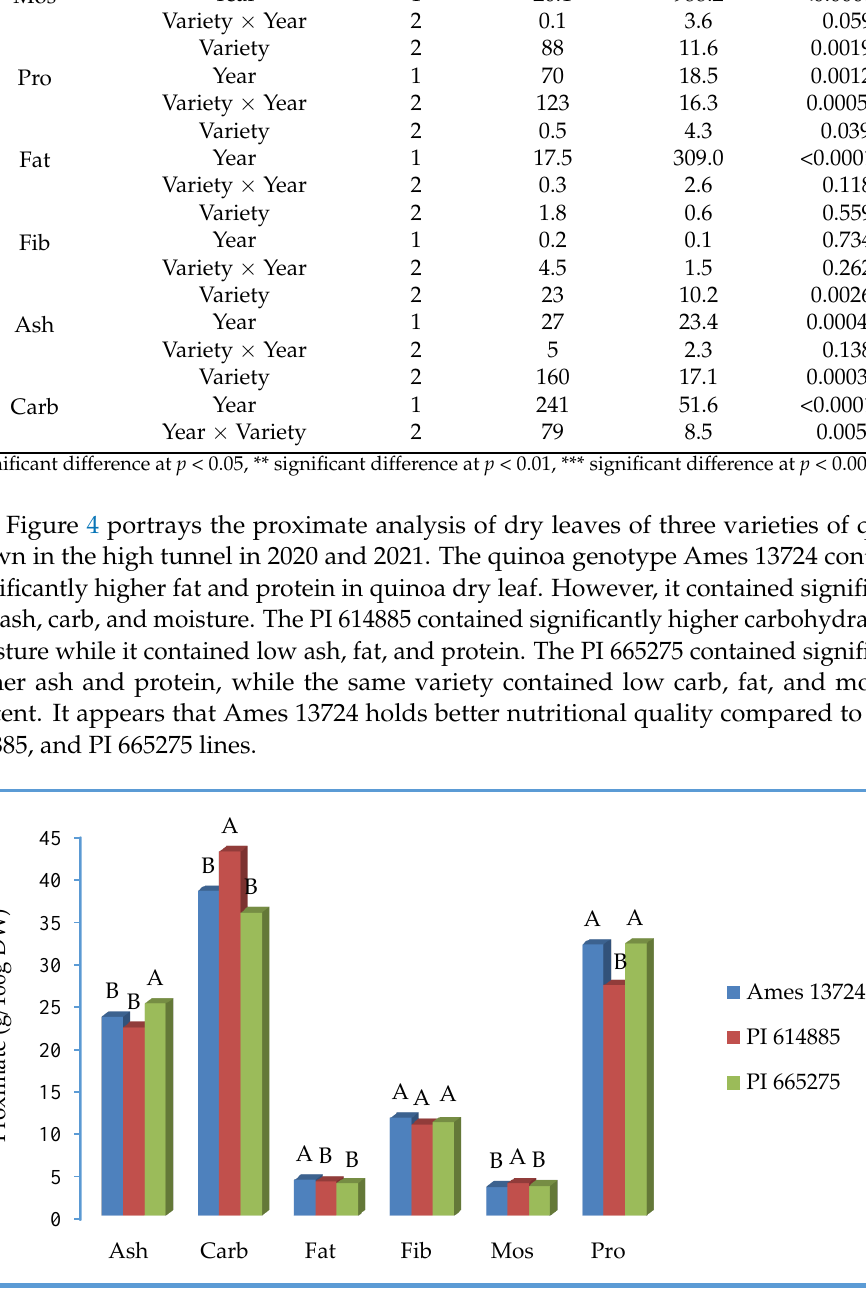
Figure 4. Proximate analysis (g per 100 g DW) of dry leaves of three varieties of quinoa grown in the high tunnel in 2020, and 2021, Lincoln University Carver farm, Jefferson City, MO, USA. Different letters suggest significant differences among means within a column indicated by Tukey’s HSD test at p ≤ 0.05.